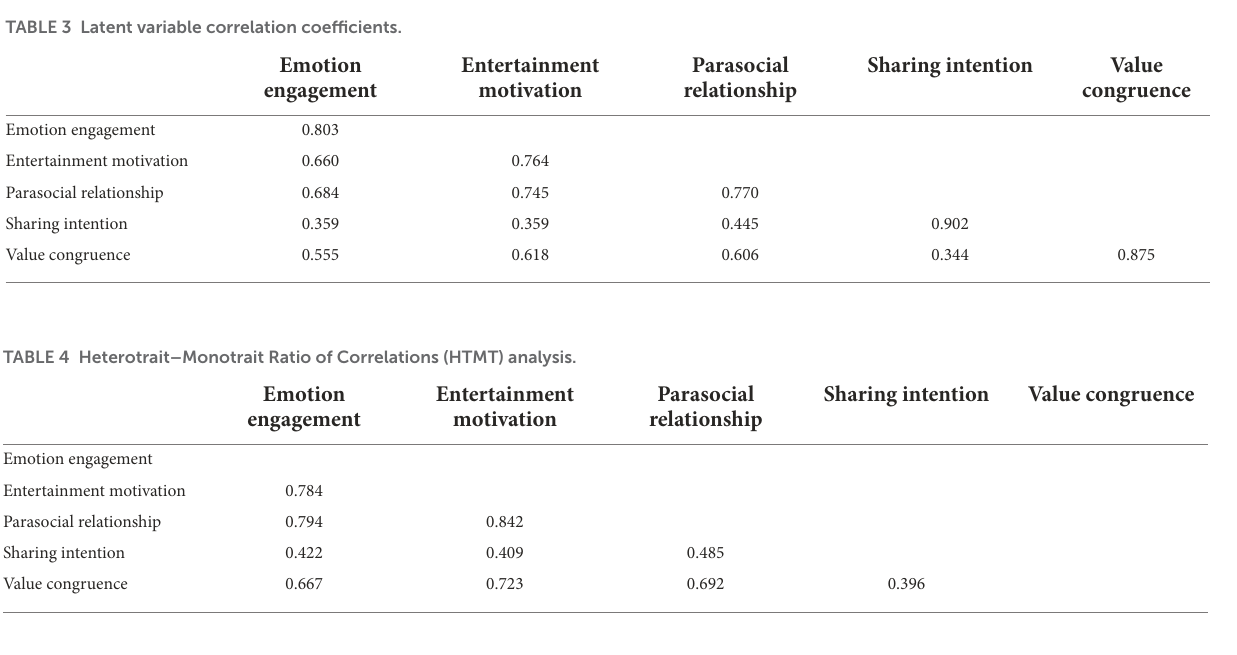
TABLE 5 Path coefficients in the structural model.